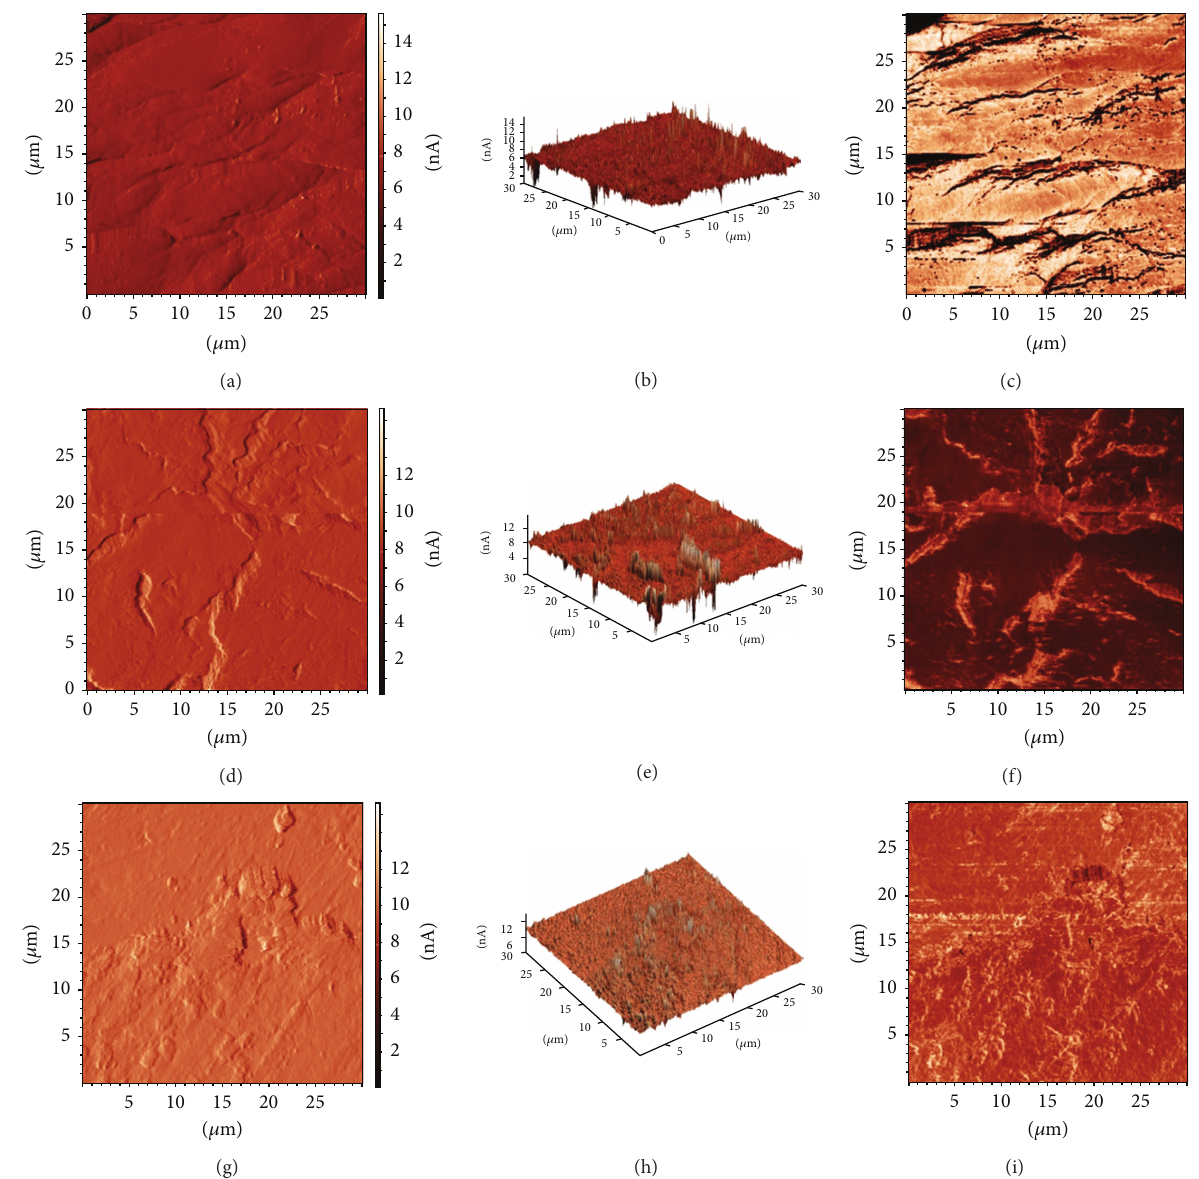
Figure 4: AFM images of composites: (a) 2D, (b) 3D, (c) phase contrast images of P 3 , (d) 2D, (e) 3D, (f) phase contrast images of P 3 after 300 h exposure at UV, (g) 2D, and (h) 3D, (i) phase contrast images of P 3 after 600h exposure at UV. Images were recorded on semicontact (tapping) mode ( 30 × 30 𝜇 m 2 ) with resolution of 256 × 256